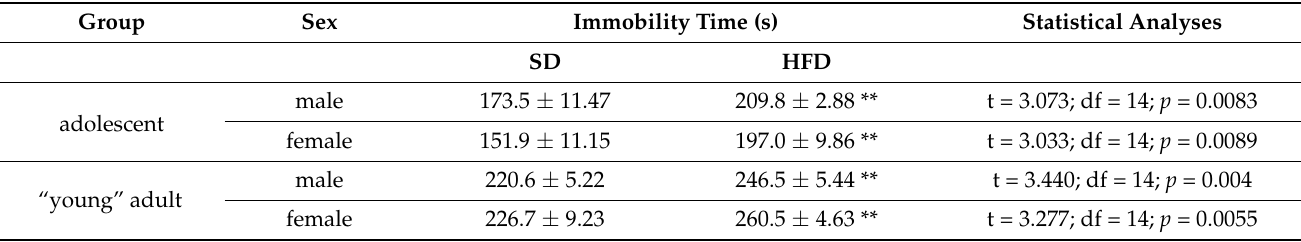
Table 1. The immobility time in the forced swimming test in male and female offspring rats whose mothers were fed on an HFD at postnatal days (PNDs) 34 and